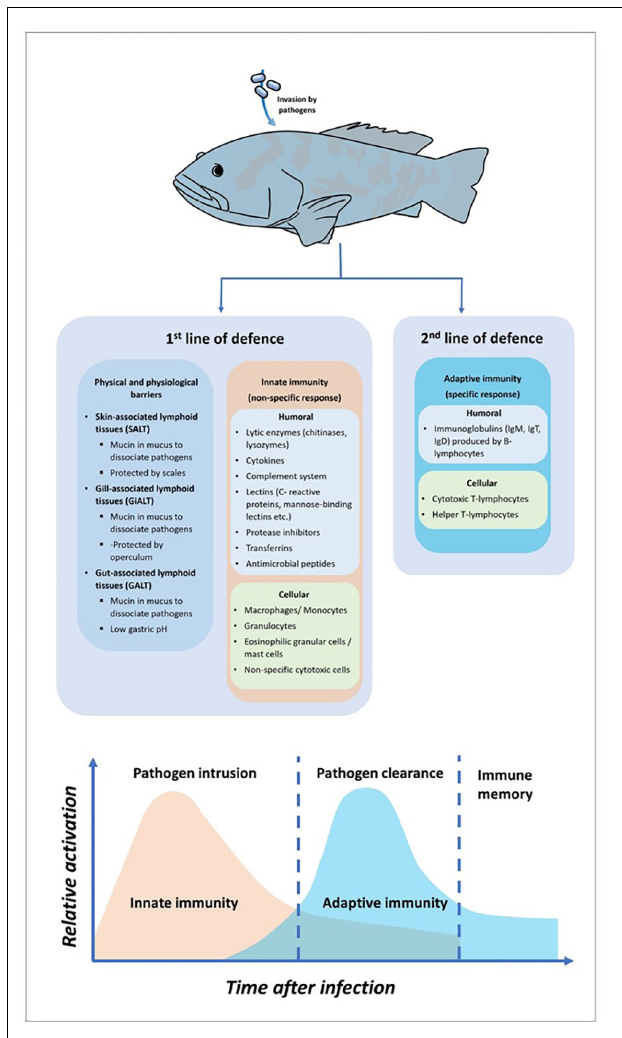
FIGURE 1 | General components of fish immune response against pathogens invasion.